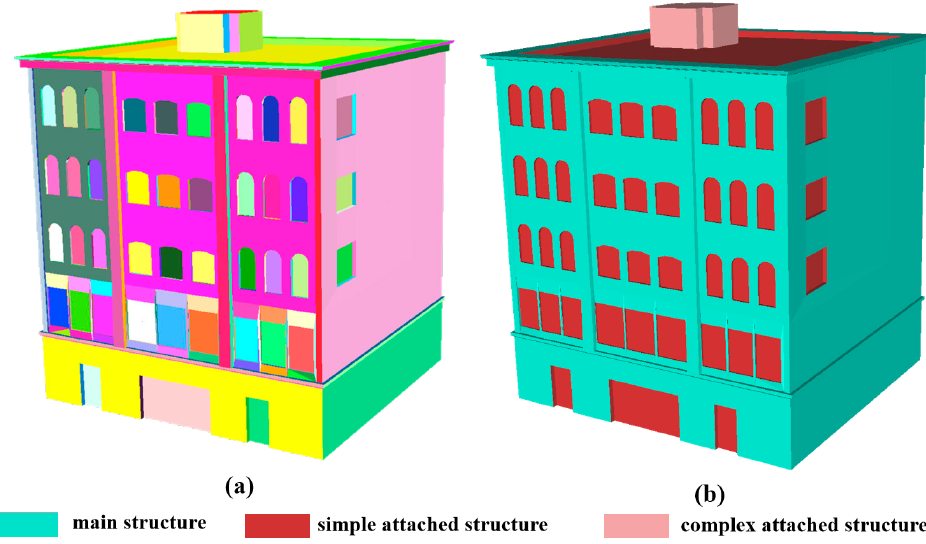
Figure 4. Face clustering and attached structure extraction: ( a ) face clustering result of main components, and ( b ) attached structure extraction result.